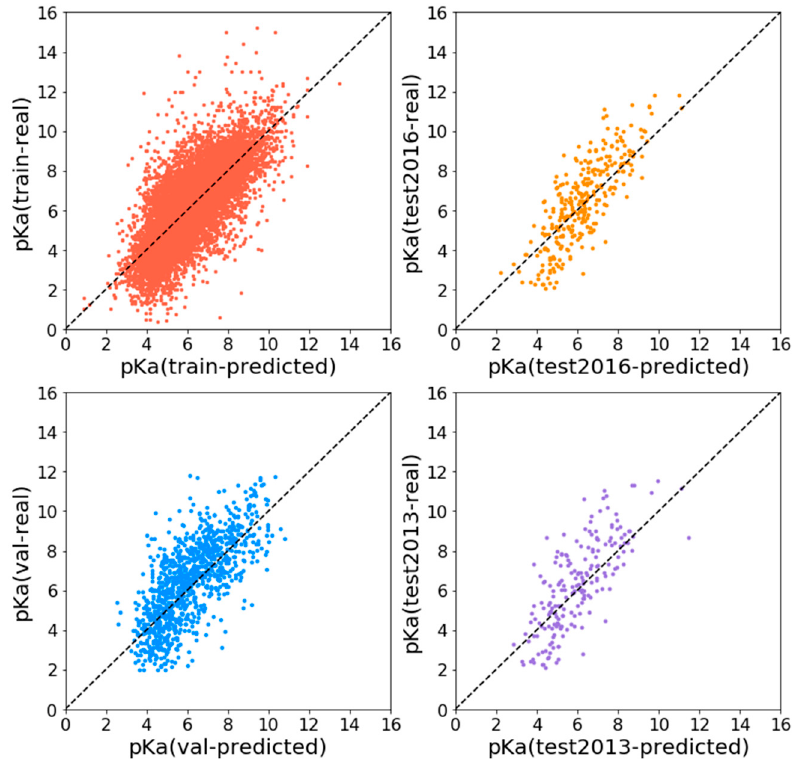
Figure 1. Scatter plots of predicted and true values on different data sets.